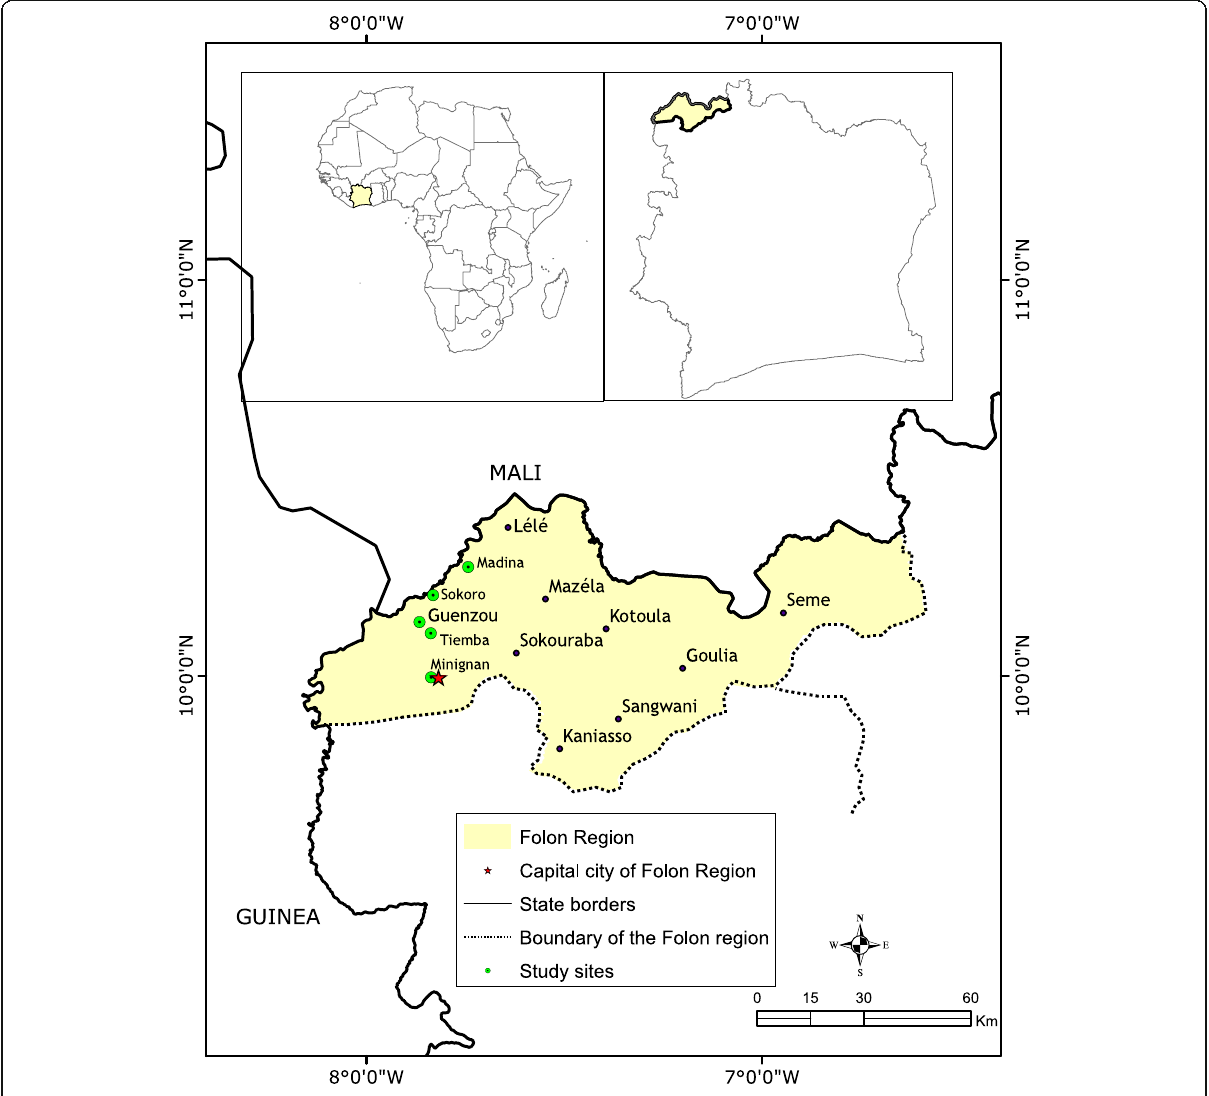
Fig. 1 Map of the Folon region indicating study